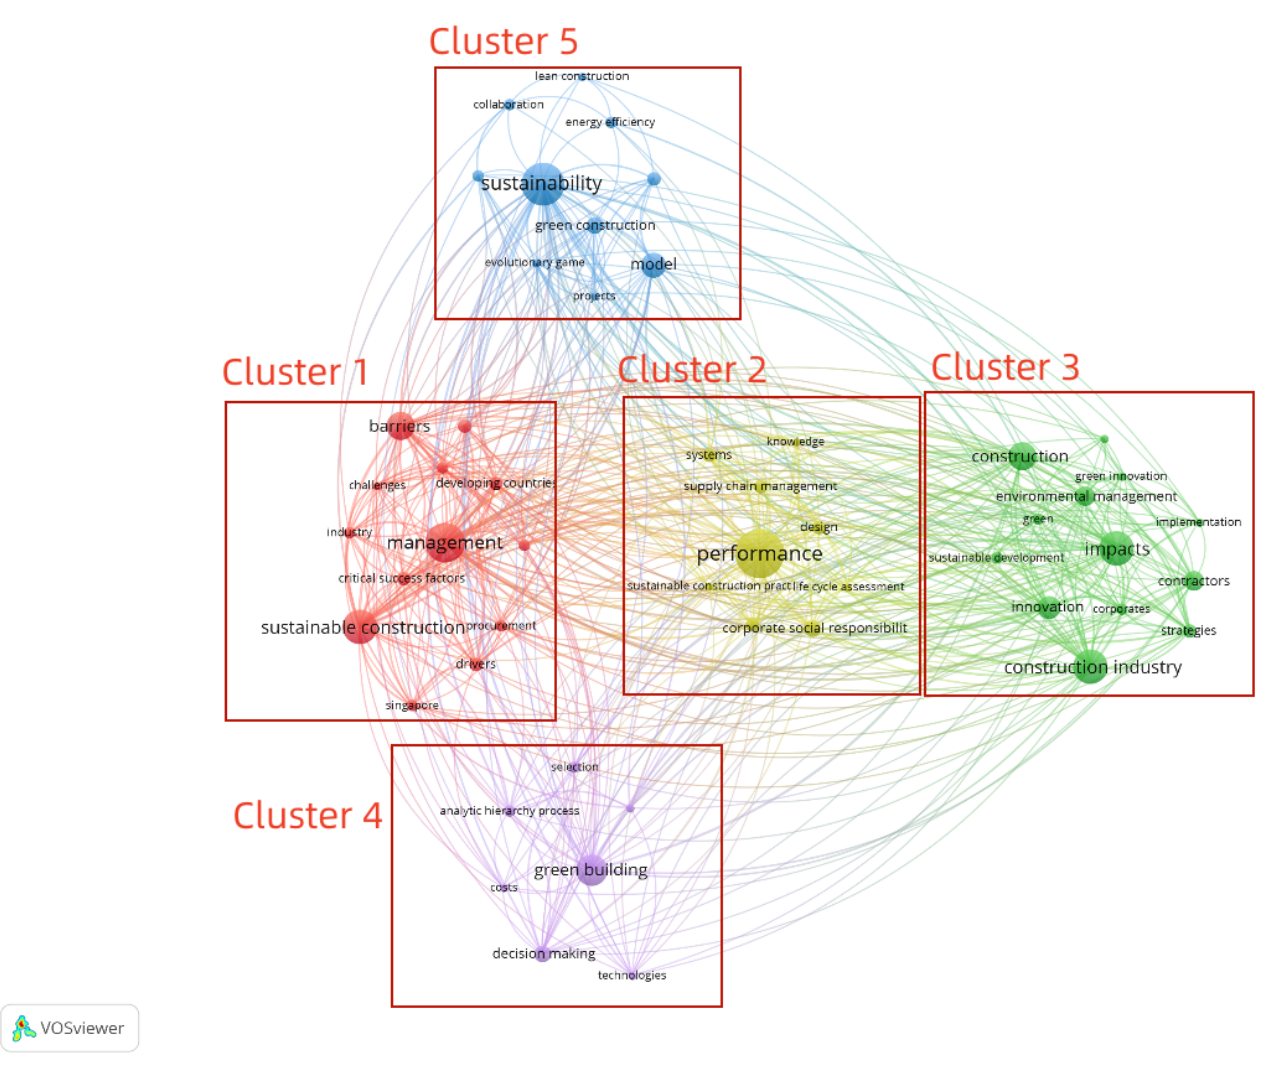
Figure 9. Map of main research topics.